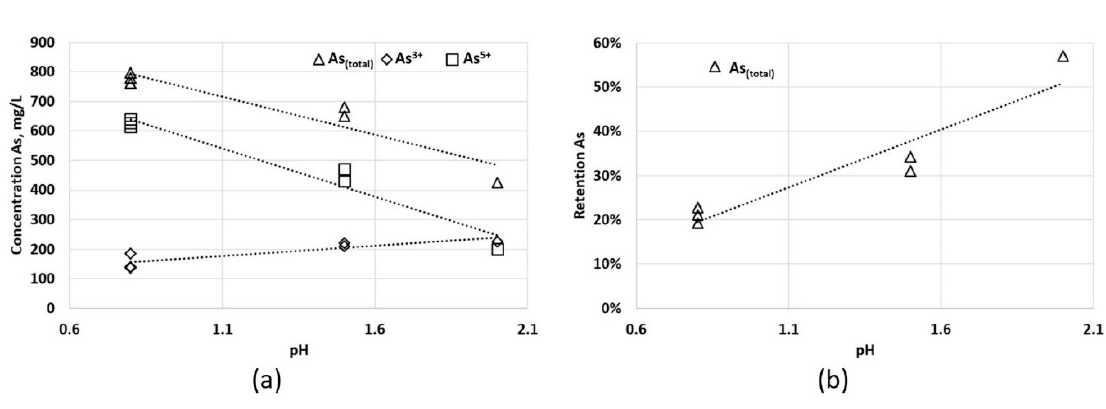
Figure 4. ( a ) As concentration in solution and ( b ) As retention in function of the pH (0.8 to 2) and Eh (510 to 540 mV).